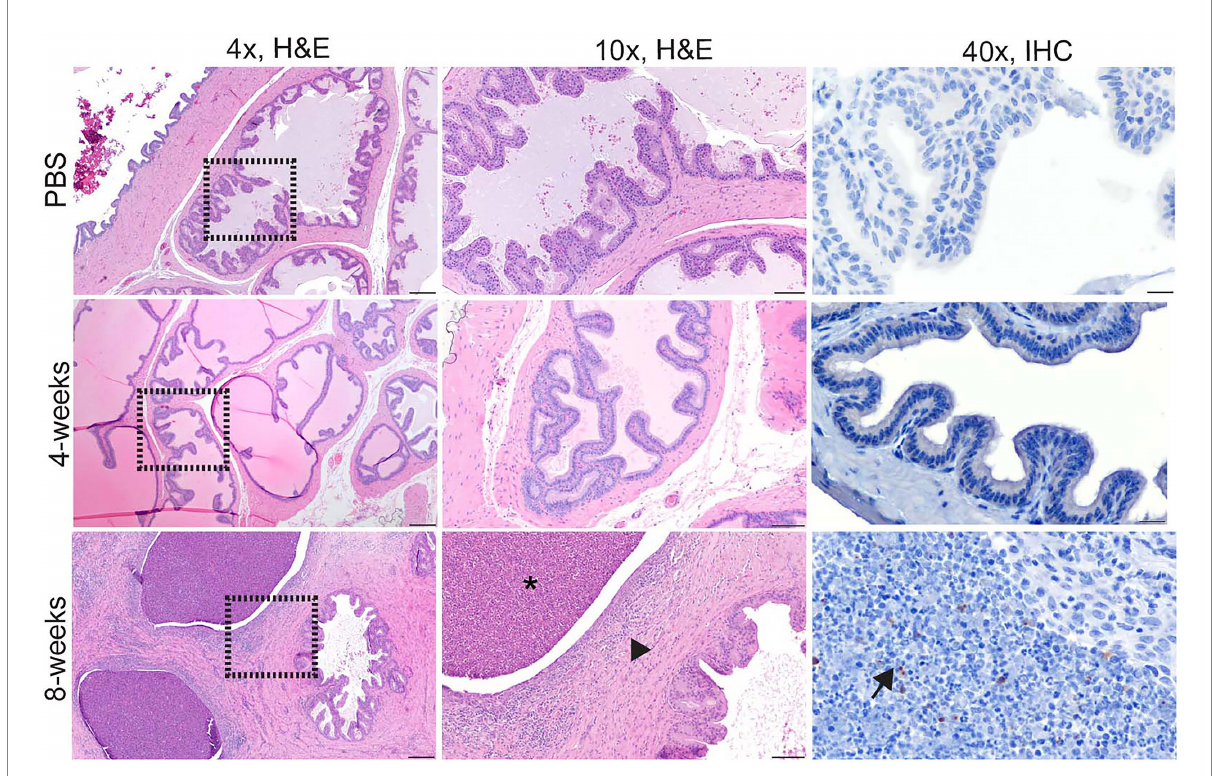
FIGURE 5 Intratracheal inoculation with 16 M B. melitensis in the guinea pig results in prostatitis at the chronic time point. Prostate from guinea pigs at the acute (4-week p.i.) and chronic (8-weeks p.i.) stages of infection following IT inoculation with 10 7 B. melitensis . Two guinea pigs in the chronic group had abundant fibrosis separating the glands (arrowhead) with infiltrates of lymphocytes and plasma cells. The prostatic glands were dilated and contained abundant degenerate neutrophils and cellular debris (*). IHC of the prostate lesion revealed extracellular Brucella antigen within the area of cellular debris (arrow). Tissues were stained with hematoxylin and eosin (H&E) and a polyclonal Brucella antibody (IHC) at 1:500 with Gill’s hematoxylin counterstain. Dashed box of 4x image indicates area highlighted for the 10x and 40x images. 4x, scale bar = 100 μ m; 10x, scale bar = 50 μ m; 40x, scale bar = 10 μ